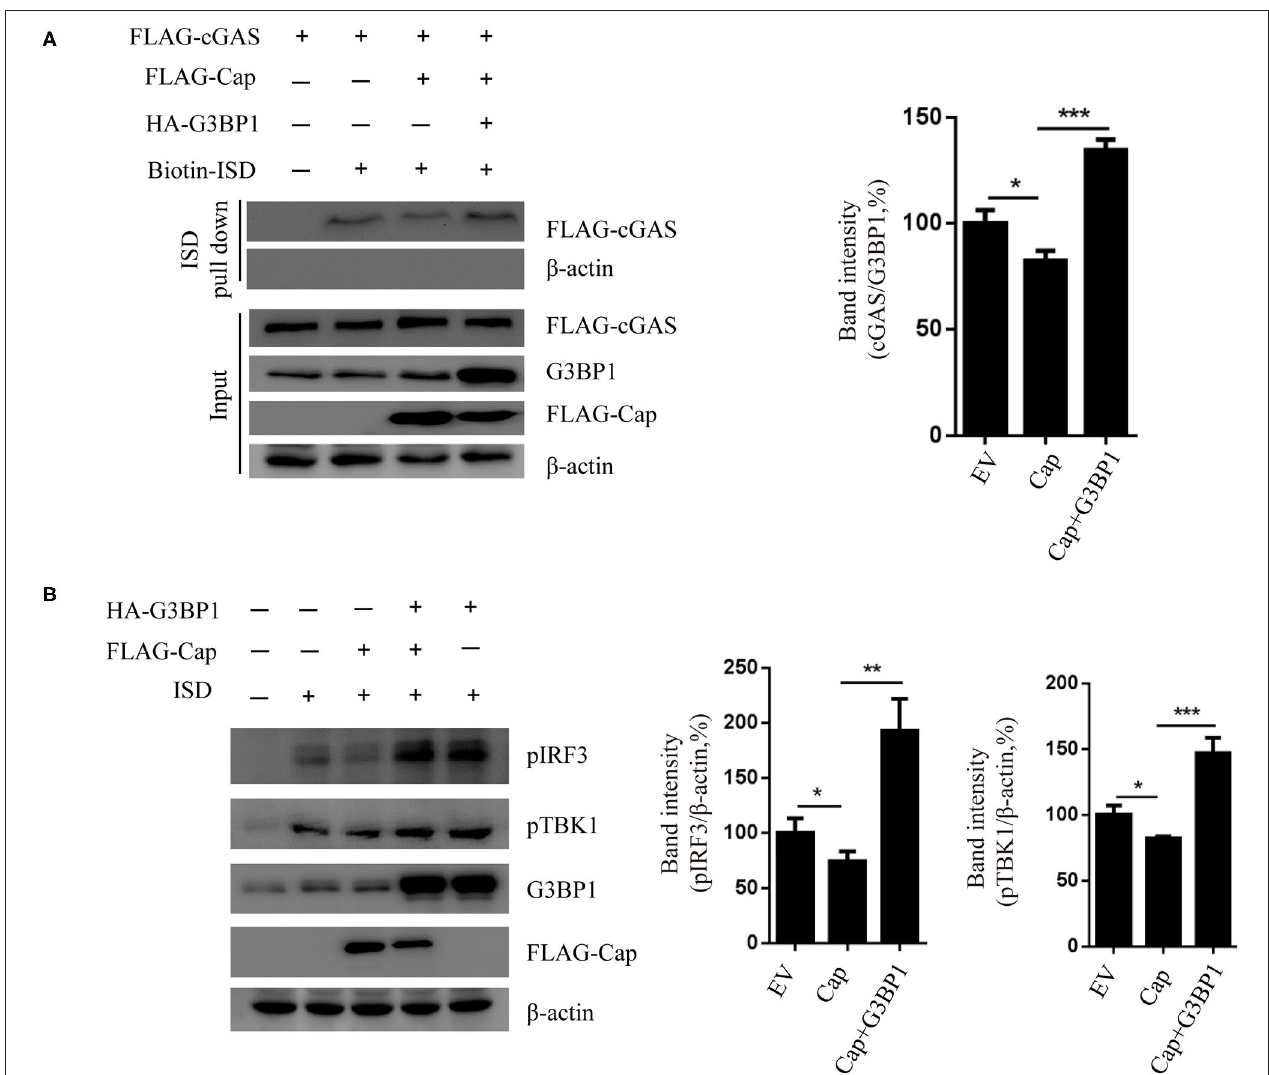
FIGURE 6 | G3BP1 reduces the inhibition activity of Cap on cGAS-STING signaling. (A) Cap inhibited ISD binding to cGAS and overexpression of G3BP1 reversed this effect. HEK 293T cells co-transfected with indicted vector and transfected with biotin-ISD (2 µ g/well) 24h after the vector transfection. The cell lysates were used for DNA pull-down assays and western blotting. (B) Cap inhibits TBK1 and IRF3 phosphorylation, whereas G3BP1 has the opposite effect. PK15 cells were transfected with the expression vector indicated and then transfected with ISD (2 µ g/ml) 24h after the vector transfection. The cells were lysed and used for western blotting analysis. The results represent data from three independent experiments, * p < 0.05; ** p < 0.01; *** p <